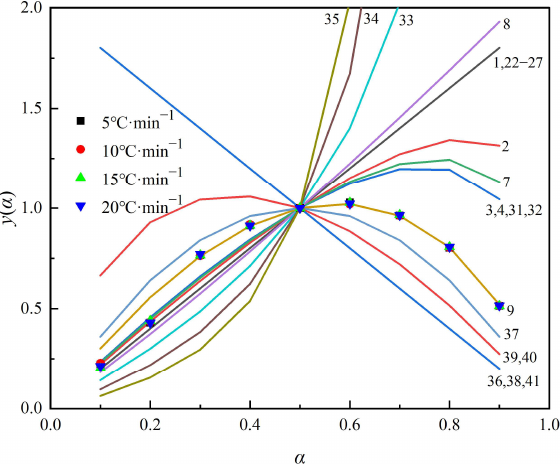
Figure 11. Standard curves and experimental data based on Malek method for samples.